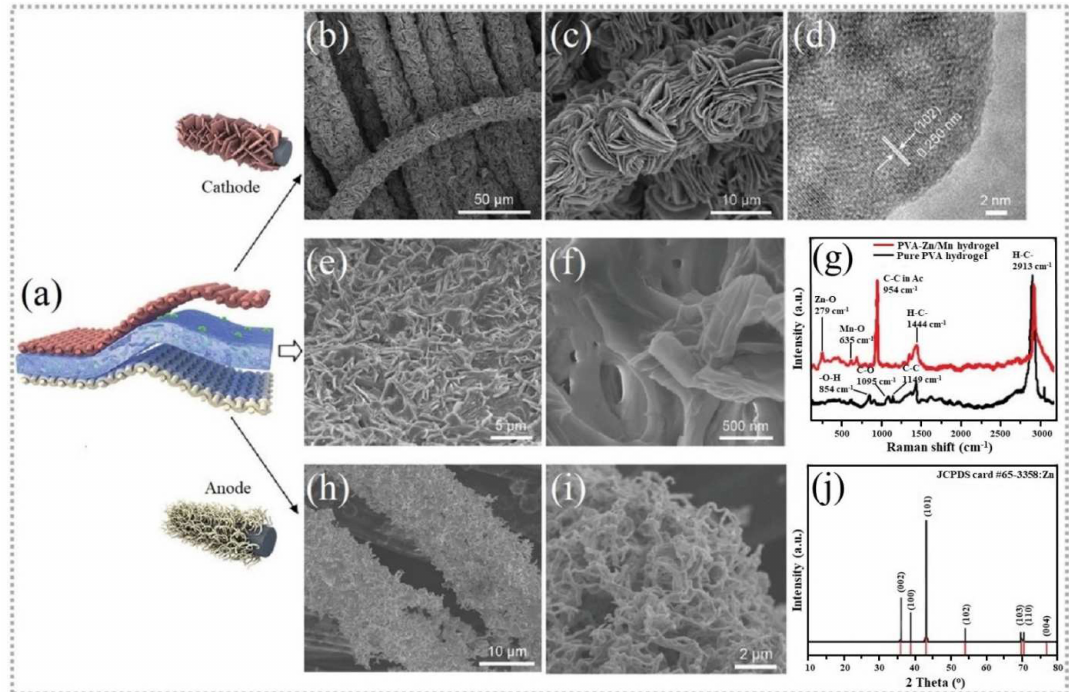
Figure 5. ( a ) Illustration of the self-healing flexible Zn-ion battery. ( b ) Low- and ( c ) high-magnification SEM images of the VS 2 nanosheets/CC cathode. ( d ) HRTEM image of a VS 2 nanosheet. The lines at the bottom indicate the standard peak position. ( e ) Low- and ( f ) high-magnification SEM images of the PVA–Zn/Mn hydrogel electrolyte. ( g ) Raman shift of PVA–Zn/Mn hydrogel and the pure PVA hydrogel. ( h ) Low- and ( i ) high-magnification SEM images of the Zn nanowires/CC anode. ( j ) XRD pattern of the Zn/CC anode. Reprinted from Ref.